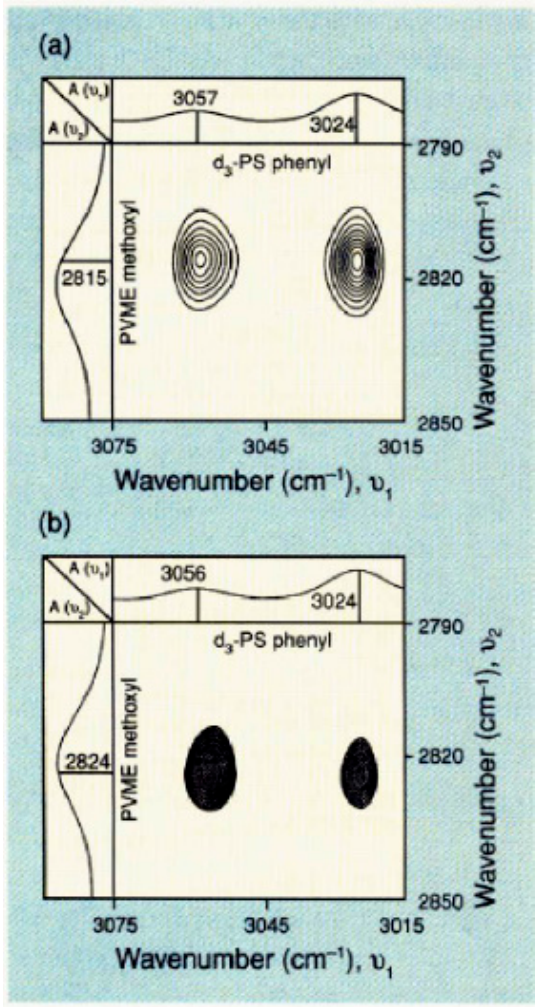
Figure 2. Two-dimensional infrared (2D IR) of a miscible blend (25:75) of deuterated polystyrene (d 3 -PS) and poly(vinyl methyl ether) (PVME): ( a ) synchronous; ( b ) asynchronous. Reproduced with permission from [42]. Copyright American Chemical Society (ACS) Publications, 1994